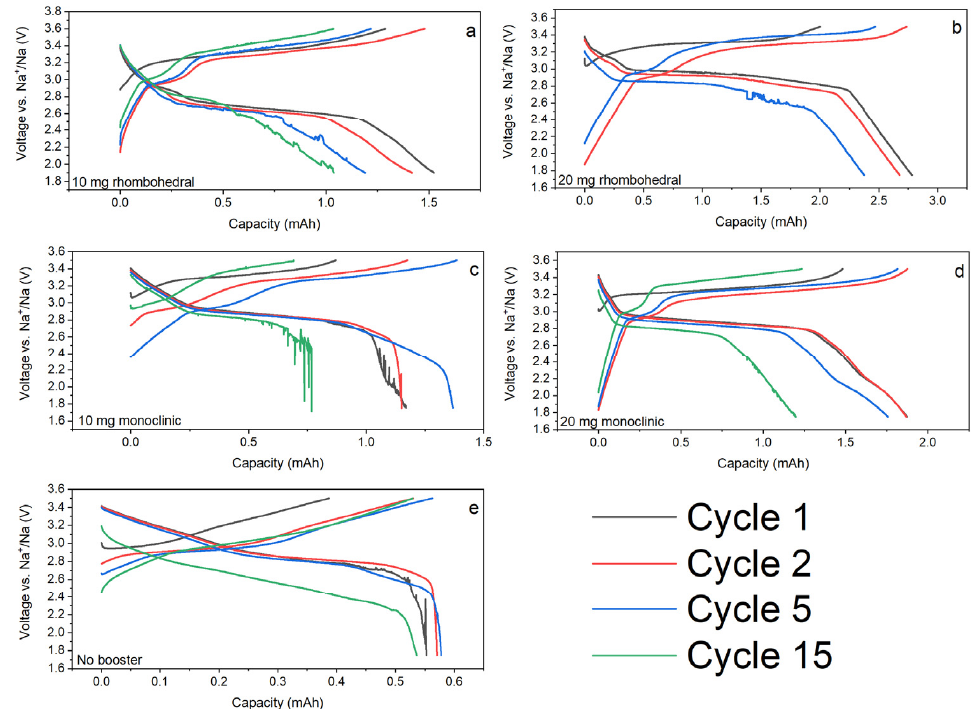
Figure 5. Evolution of the voltage profiles in cycles 1, 2, 5, and 15 for the cells. Booster loading was 10 mg and 20 mg rhombohedral PB ( a , b ) or equivalent amount of monoclinic PB booster ( c , d ). An identical cell without booster is also shown ( e ).